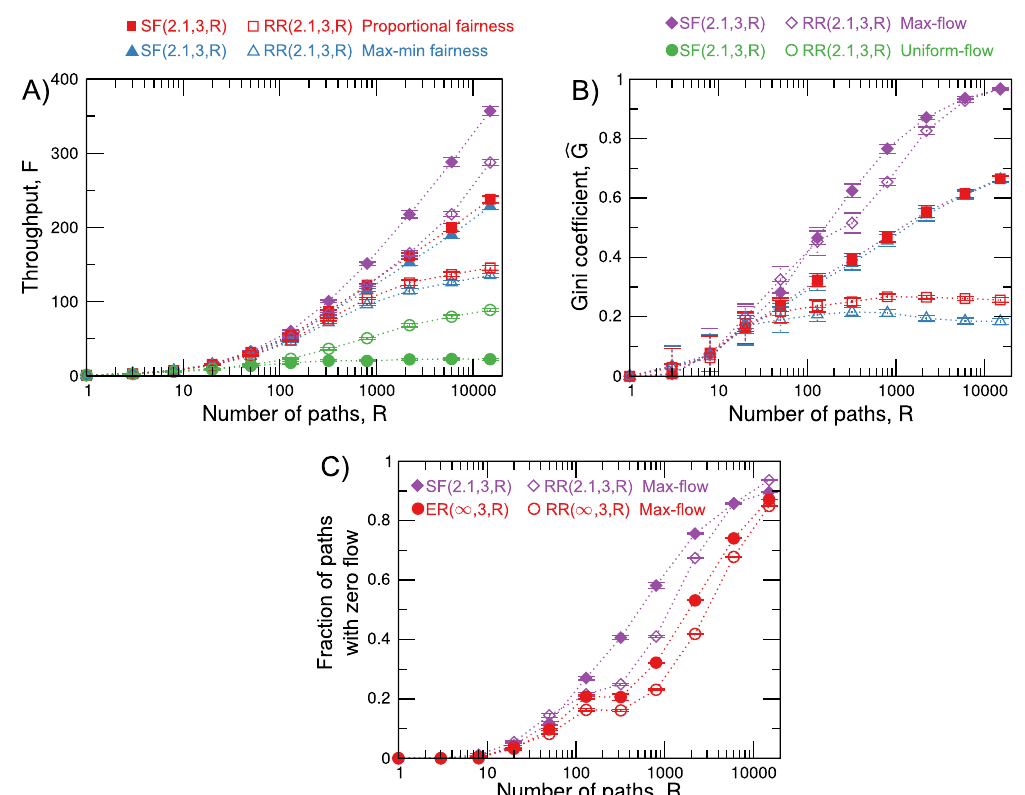
Figure 2. ( A ) Average network throughput and ( B ) Average Gini coefficient of path flows in scale-free and random regular networks for γ = 2.1 and 〈 K 〉 = 3 as a function of the number R of shortest paths for max-flow, proportional fairness, max-min fairness, and uniform-flow. ( C ) The average fraction of paths that are allocated zero flow by the max-flow algorithm as a function of the number R of shortest paths in scale-free networks ( γ = 2.1, 〈 K 〉 = 3), Erdös-Rényi networks ( 〈 K 〉 = 3), and their random counterparts. For each network structure, we average over 20 randomly generated networks with N = 2000 nodes. Whiskers show the 95% confidence